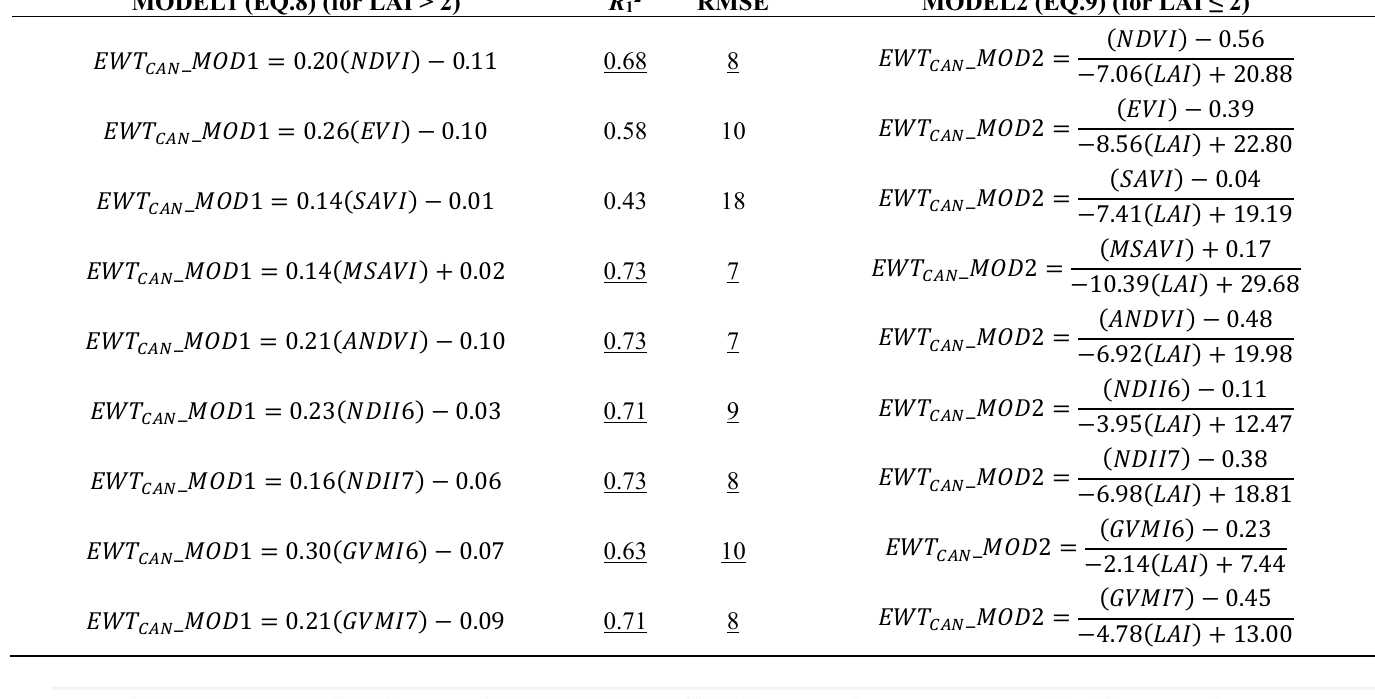
Table 5. Inversion models for EWT CAN (g∙cm −2 ) retrieval from biomass vegetation indexes (BVI), moisture vegetation indexes (MVI) and LAI. R 2 > 0.60 and the corresponding RMSE are underlined. Conditions imposed on VI are to avoid negative EWT values. MODEL1 (EQ.8) (for LAI >